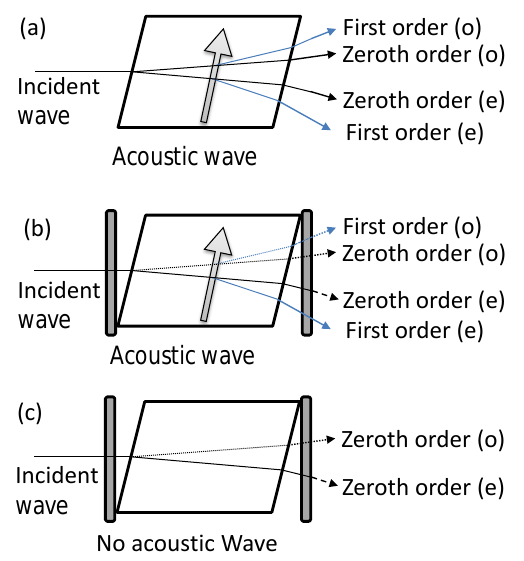
Figure 2. (a) A representative AOTF undergoing Bragg diffraction with an unpolarized incident wave with a RF wave applied repre- sented by the arrow. After the diffraction event four output signals are formed: the zeroth-order and first-order ordinary (o) and extraor- dinary (e) signals. However, the only optical path that remains at a constant angle no matter the applied RF wavelength is the first- order extraordinary diffracted signal. (b) Two linear polarizers are added to the system: the first linear polarizer removes the ordinary polarization removing the outputs with the dotted lines and the sec- ond linear polarizer removes undiffracted extraordinary light shown by the dashed line. (c) The system in (b) without a RF wave so Bragg diffraction is not occurring. Once again the first linear po- larizer removes the ordinary polarization represented by the dotted line and the second linear polarizer removes the extraordinary light shown by the dashed